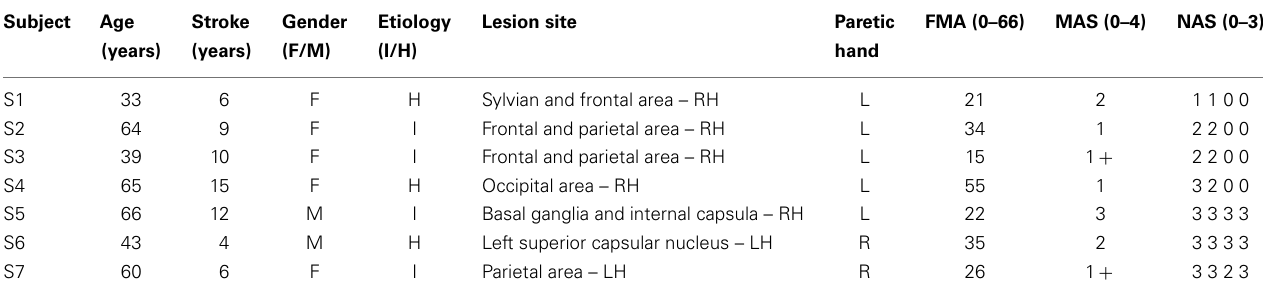
Table 1 | Record and clinical data of subjects .